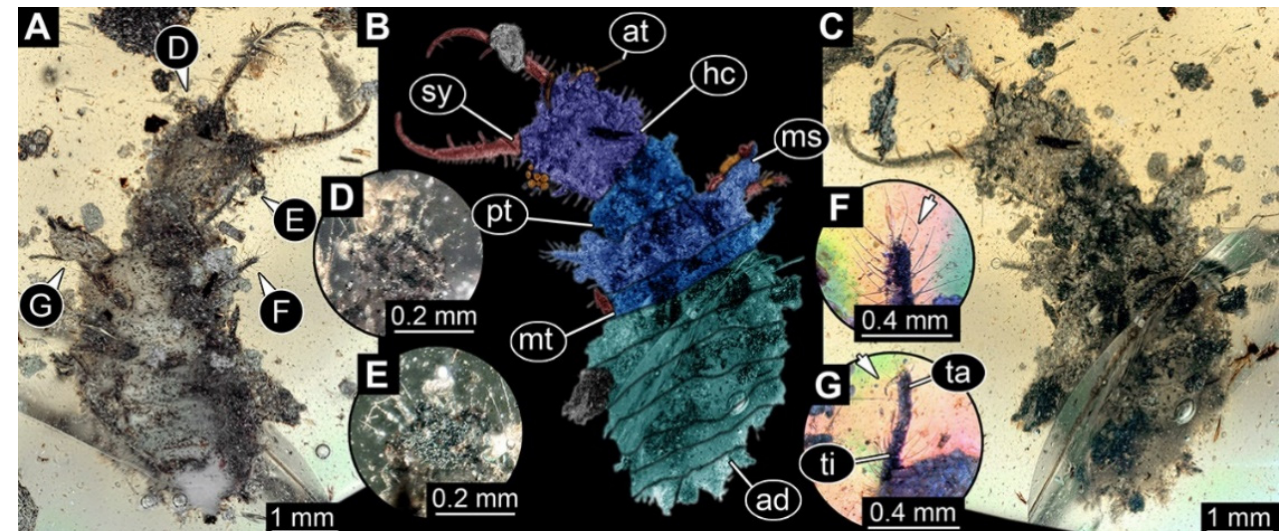
Figure 6. Fossil owllion larva, specimen 3217 (BUB 3348), Cretaceous Kachin amber, Myanmar. ( A ) Overview, ventral. ( B ) Color-marked version of ( C ). ( C ) Overview, dorsal. ( D , E ) Close-ups of fields of stemmata. ( F ) Close-up on dorsal process (arrow). ( G ) Close-up on locomotory appendage with distal claws (arrow). Abbreviations: ad = abdomen; at = antenna; hc = head capsule; ms = mesothorax; mt = metathorax; pt = prothorax; sy = stylet; ta = tarsus; ti = tibia.